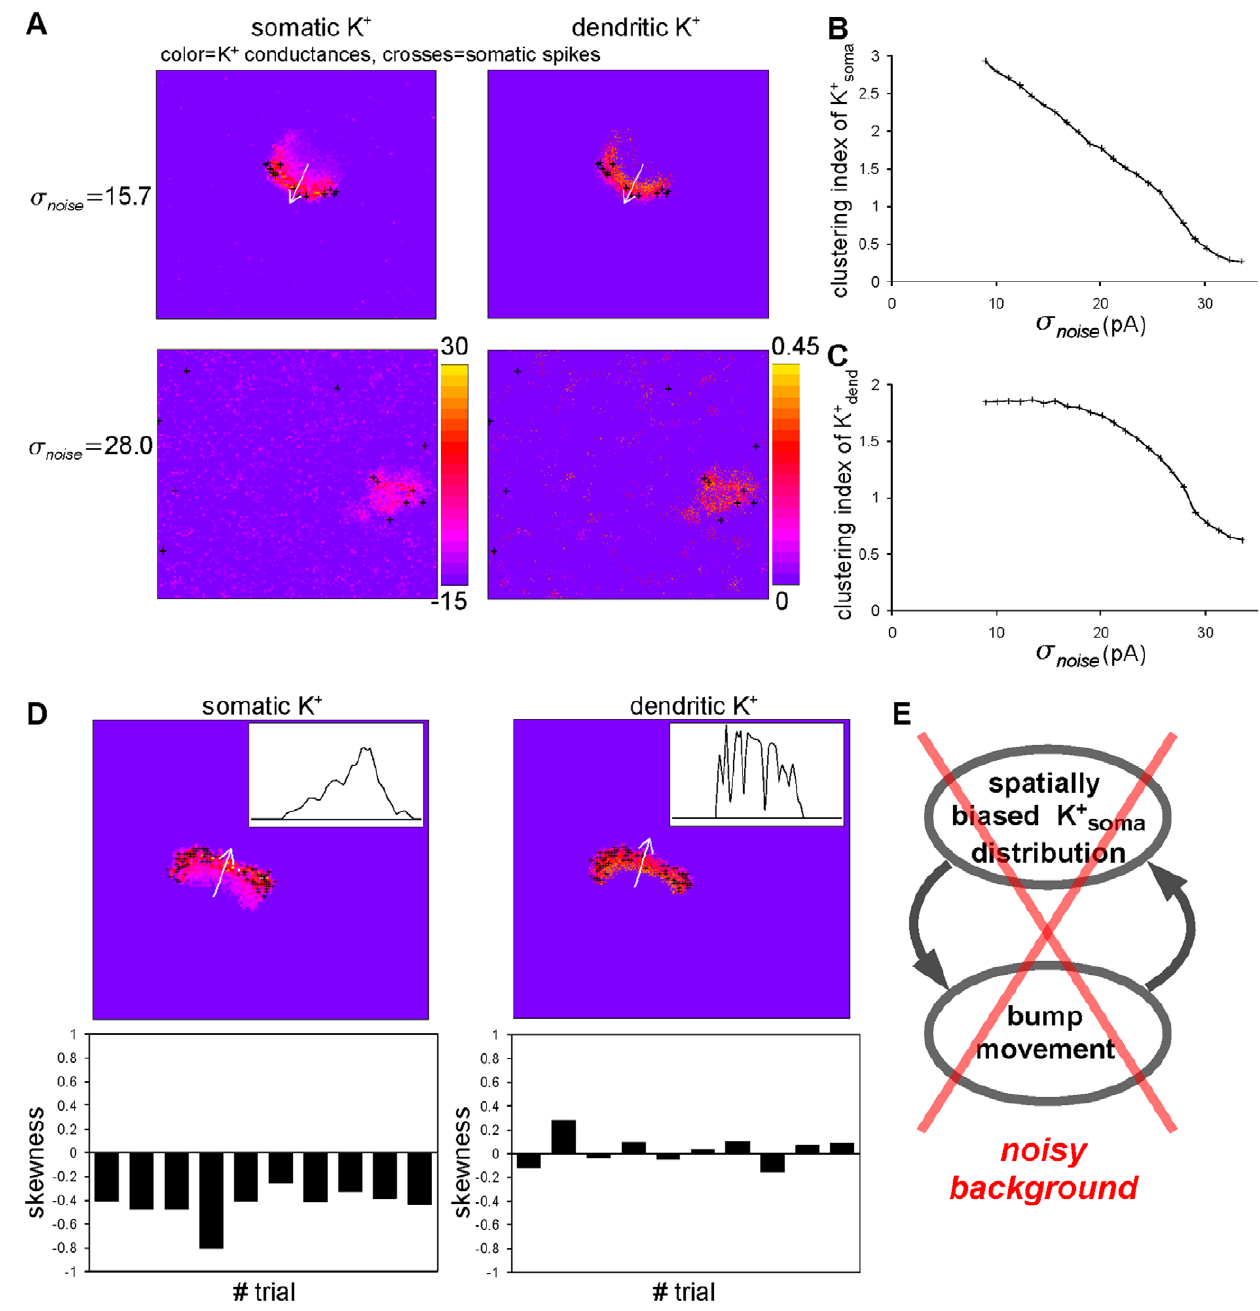
Figure 5. Mechanism for the moving and immobilization of a bump. (A) Each panel color-codes somatic (left) and dendritic (right) K z currents. Crosses depicting somatic spikes are overlaid on each panel. The K z currents were u s , m and n d , n described in Methods. The crosses indicate where somatic spikes occur at the present time. The dendritic time constant was set to t d ~ 200 ms. In a weakly noisy condition (upper row; s noise ~ 15 : 7 pA), somatic K z current is distributed in a spatially biased manner with its long-tail (left), whereas dendritic K z current is distributed in a relatively unbiased manner without a clear tail (right). In a strongly noisy condition (lower row; s noise ~ 28 : 0 pA), the bump is widely spread and K z currents appear ubiquitously on the field. (B and C) Spatial clustering of K z and K z depends on noise intensities, s noise . Both activities of K z s oma s oma d end (B) and K z (C) are clustered in weakly noisy background inputs, and become distributed with an increase in the noise intensity. (D) Spatially biased d end distribution of somatic K z activity (left) and unbiased distribution of dendritic K z (right) activity along the direction of the bump movement indicated by the white arrow in a weakly noisy background. s noise ~ 15 : 7 pA. The inset shows the one dimensional distributions of the K z current by the white arrows. The skewness values calculated from the one dimensional distributions are shown at ten different points in time. In somatic K z activity, spatially biased distributions are clearly found. (E) A schematic diagram showing the self-regenerative loop. In the noisy condition, the bump is immobile because generation of the loop is obstructed by the noise.